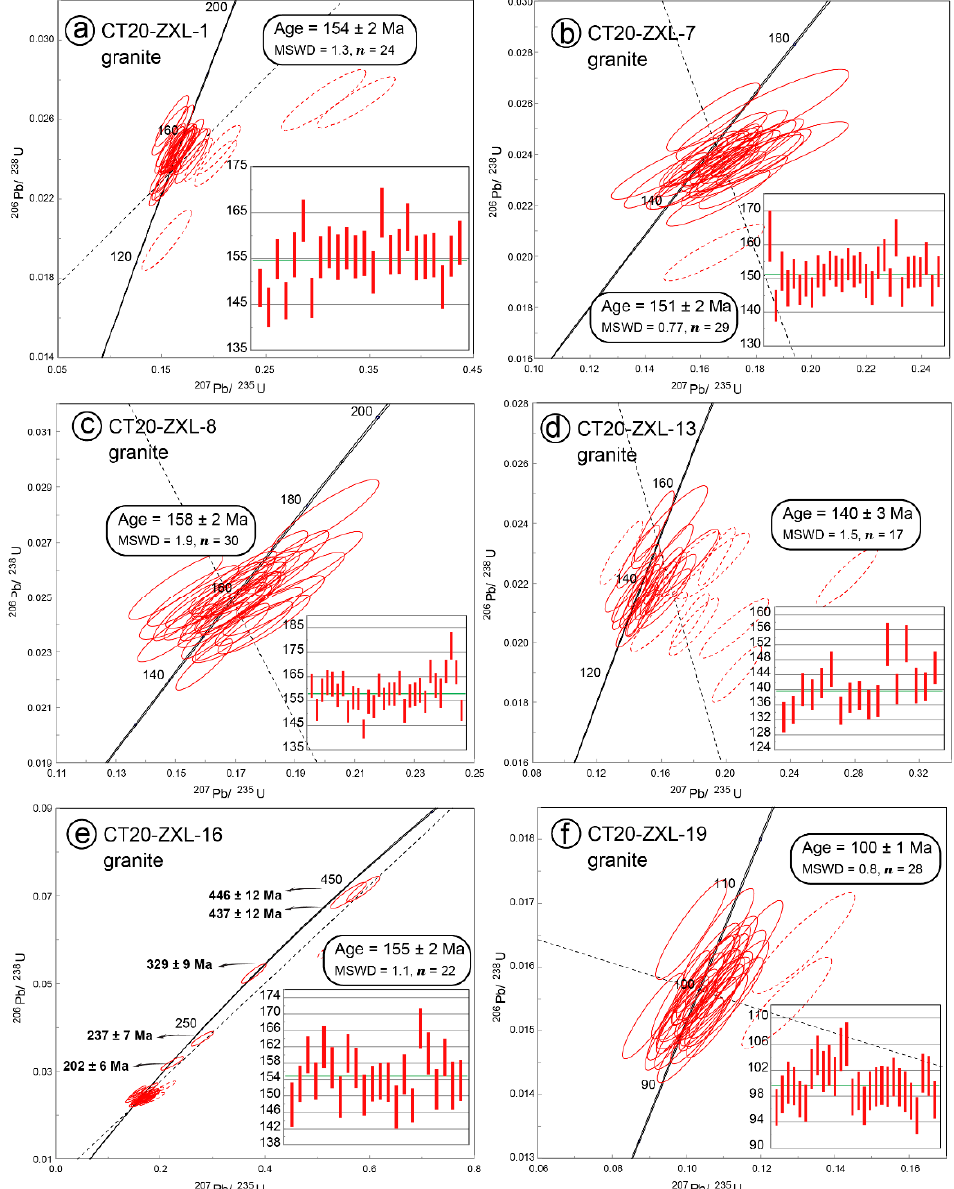
Figure 13. U-Pb Concordia diagrams for samples from the Yanshanian intrusions that developed around or in the Taoxi dome. ( a ) Concordia diagram and weighted average age diagram of sample CT20-ZXL-1. ( b ) Concordia diagram and weighted average age diagram of sample CT20-ZXL-7. ( c ) Concordia diagram and weighted average age diagram of sample CT20-ZXL-8. ( d ) Concordia diagram and weighted average age diagram of sample CT20-ZXL-13. ( e ) Concordia diagram and weighted average age diagram of sample CT20-ZXL-16. ( f ) Concordia diagram and weighted average age diagram of sample CT20-ZXL-19.